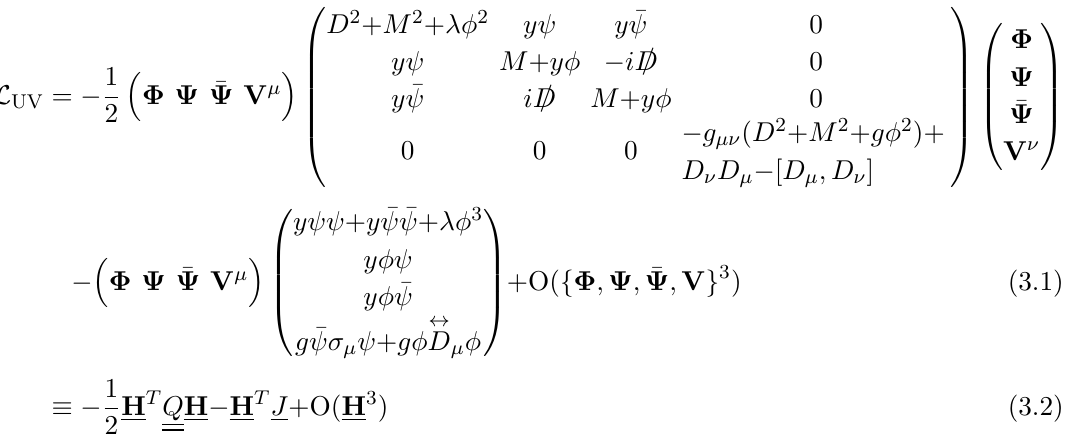
Figure 1 . The classes of dimension six operators in the space of the number of (cid:12)elds contained, n , and the total helicity P h of the particles they excite. We truncate the diagram about its axis of symmetry P h = 0. Re(cid:13)ect the diagram in the n -axis by Hermitian conjugation to obtain the full set of operators. Operators in red arise at tree level in a weakly coupled renormalizable UV completion, as de(cid:12)ned in section 3. Operators in blue and black are generated at loop level, but only those in blue are renormalized by tree-level operators. Those in gray can be expressed in terms of the others by equations of motion, when considering their e(cid:11)ects in helicity amplitudes. schematic